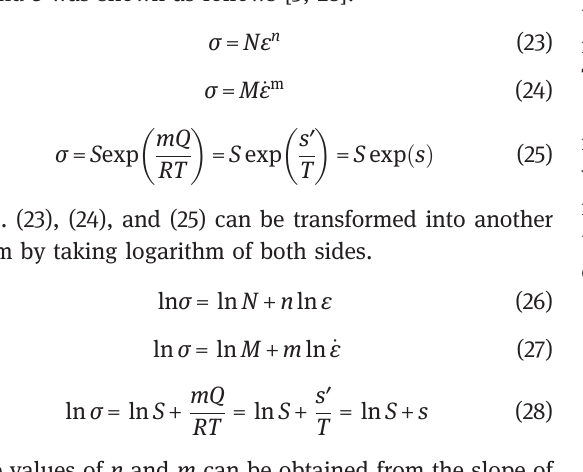
, m and s were values of intersection point. 0 0 0